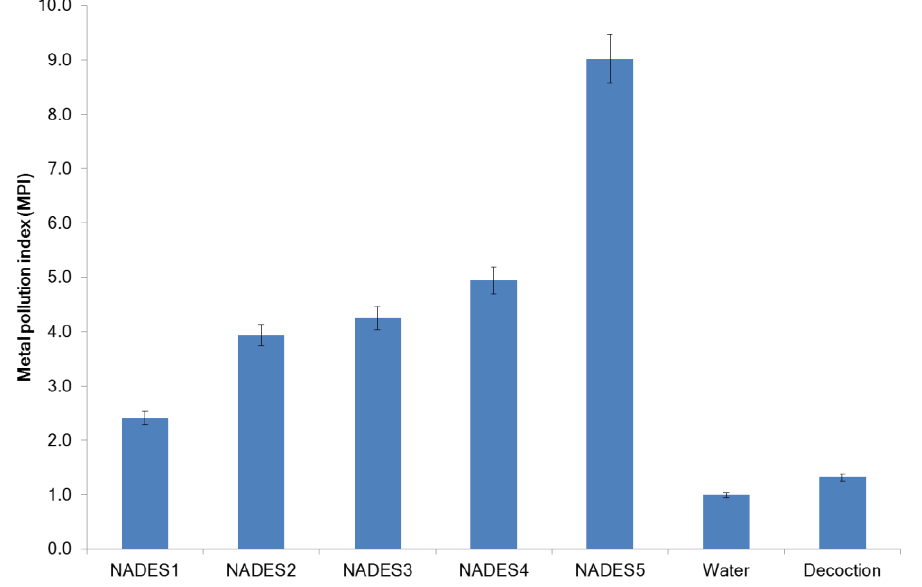
Figure 4. Cumulative accumulation of metals (MPI).